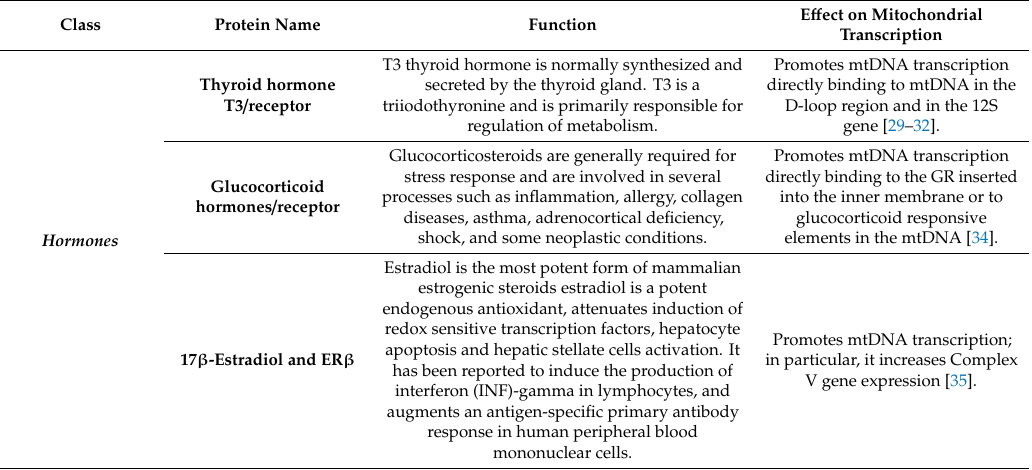
Table 1. Factors a ff ecting mitochondrial transcription. The table reports on protein belonging to the three classes of factors (hormones, chromatin remodeling enzymes, and nuclear transcription factors) mentioned in the text for their role in regulating mitochondrial transcription. The protein functions of hormones were obtained from the Human Metabolome Database, and those of all other proteins were obtained from